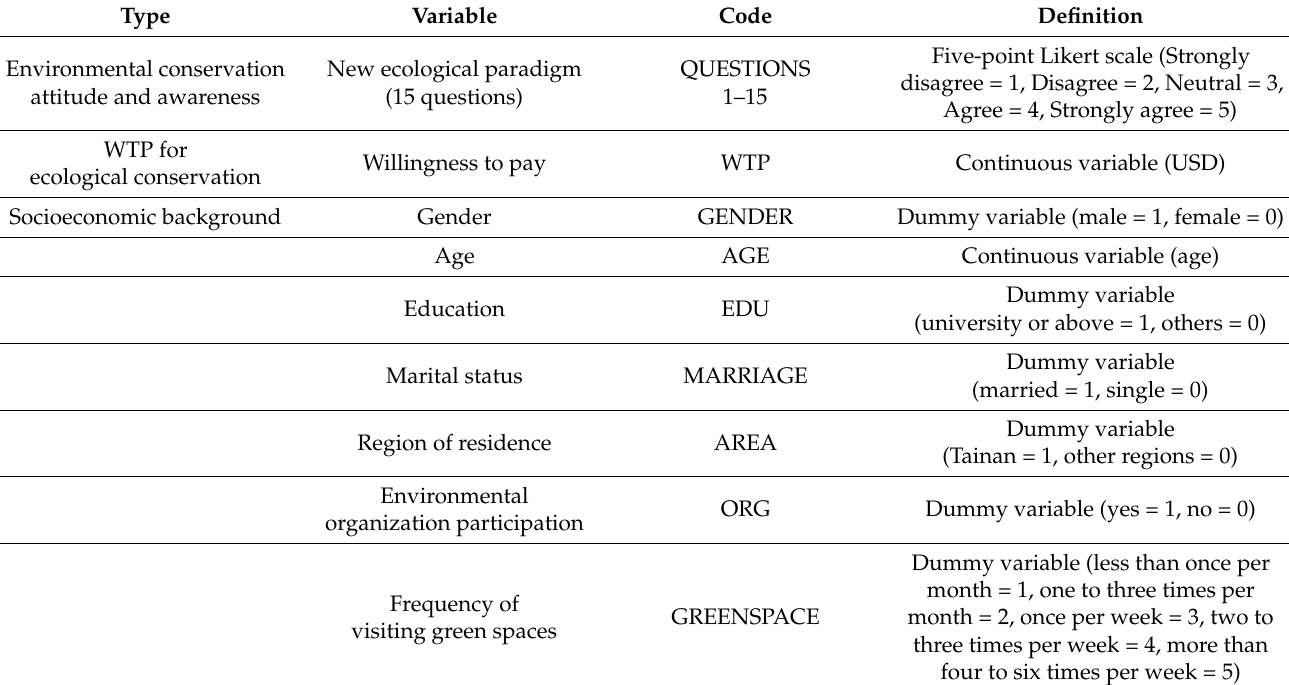
Table 2. Variable